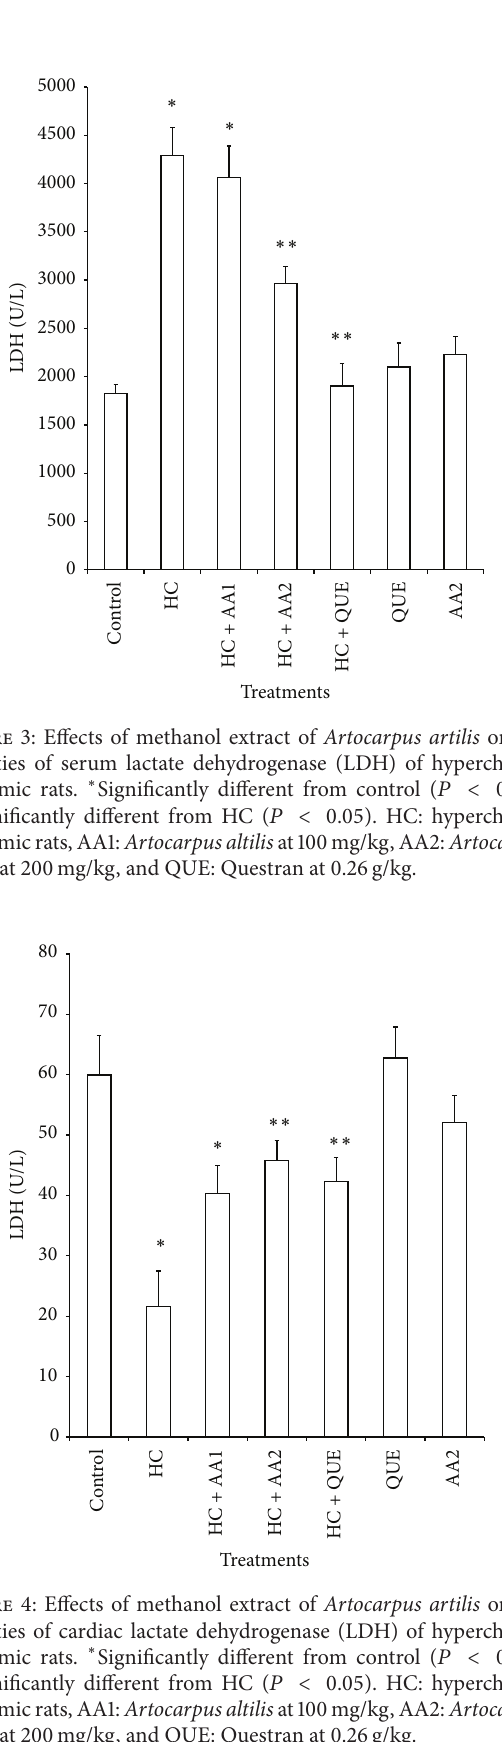
Figure 4: Effects of methanol extract of Artocarpus artilis on the activities of cardiac lactate dehydrogenase (LDH) of hypercholes- terolemic rats. ∗ Significantly different from control ( 𝑃 < 0.05 ), ∗∗ significantly different from HC ( 𝑃 < 0.05 ). HC: hypercholes- terolemic rats, AA1: Artocarpus altilis at 100 mg/kg, AA2: Artocarpus altilis at 200 mg/kg, and QUE: Questran at 0.26